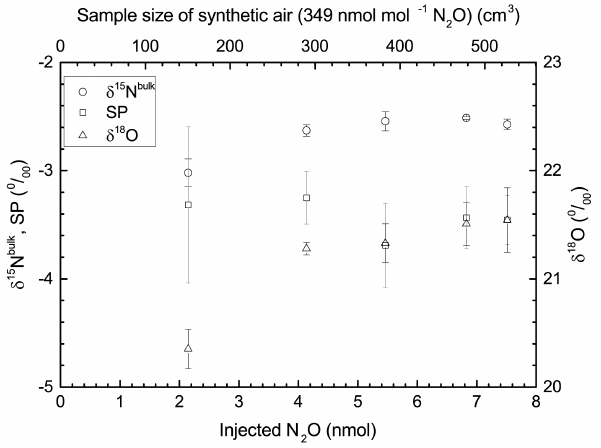
Figure 5. Precision of isotopocule ratio measurements as a function of sample